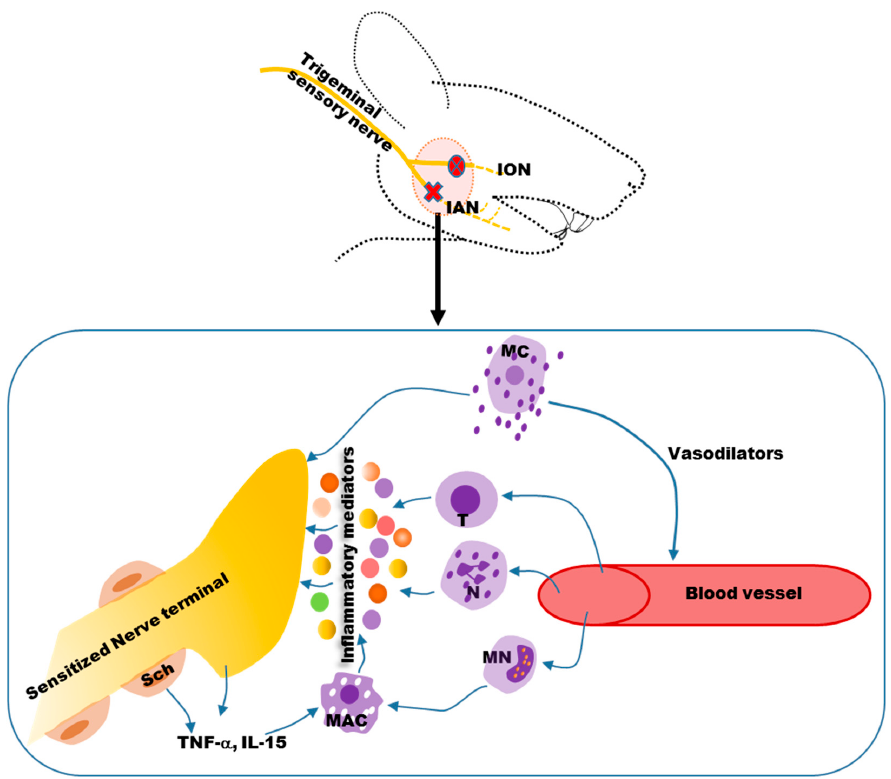
Figure 1. The immune response near the site of a nerve injury sensitizes the nerve terminals. Resident mast cells (MC) are activated and release vasodilators that act on blood vessels, leading to infiltration of immune cells, such as neutrophils, monocytes and T-lymphocytes. Monocytes differentiate into macrophages. These immune cells release inflammatory mediators that sensitize terminals of injured and uninjured nerves. Schwann cells (Sch) that cover the myelinated nerves release cytokines (e.g., TNF- α , IL-15) that also facilitate the recruitment and activation of macrophages. ION: Inferior orbital nerve; IAN: Inferior alveolar nerve; MC: Mast cell; T: T-lymphocyte; N: Neutrophil; MN: Monocyte; MAC: Macrophage; TNF- α : Tumor necrosis factor alpha; IL-15: Interleukin 15. Accumulating evidence suggests that activated glial cells in the sensory ganglia (trigeminal ganglia or dorsal root ganglia) and central nervous system also play a key role in neuropathic pain [16–19]. Glial cells are non-neuronal cells that provide support and protection for neurons in the central and peripheral nervous systems [57–59]. Small satellite glial cells (SGCs) surround the cell bodies of trigeminal ganglion and dorsal root ganglion (DRG) neurons [60]. These cells are connected by gap junctions and are thought to have similar roles to that of astroglia, in the central nervous system [61]. The satellite glial cell marker, glial fibrillary acidic protein (GFAP), increases after nerve injury in the trigeminal ganglion [62–64]. SGCs also proliferate in the trigeminal ganglion following a chronic constriction injury of the infraorbital nerve [65]. The gap junction between them increases following trigeminal nerve injury, along with a reduction in the pain threshold [64,66]. Expression of the major gap junction protein, connexin 43 (Cx43), increases in the trigeminal ganglion following inferior